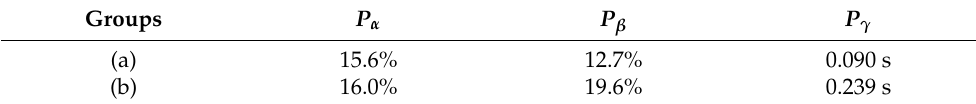
Figure 9. Steady ‐ state identification results of Experiment (i). Table 9. Calculation results of the accuracy parameters of Figure 9.